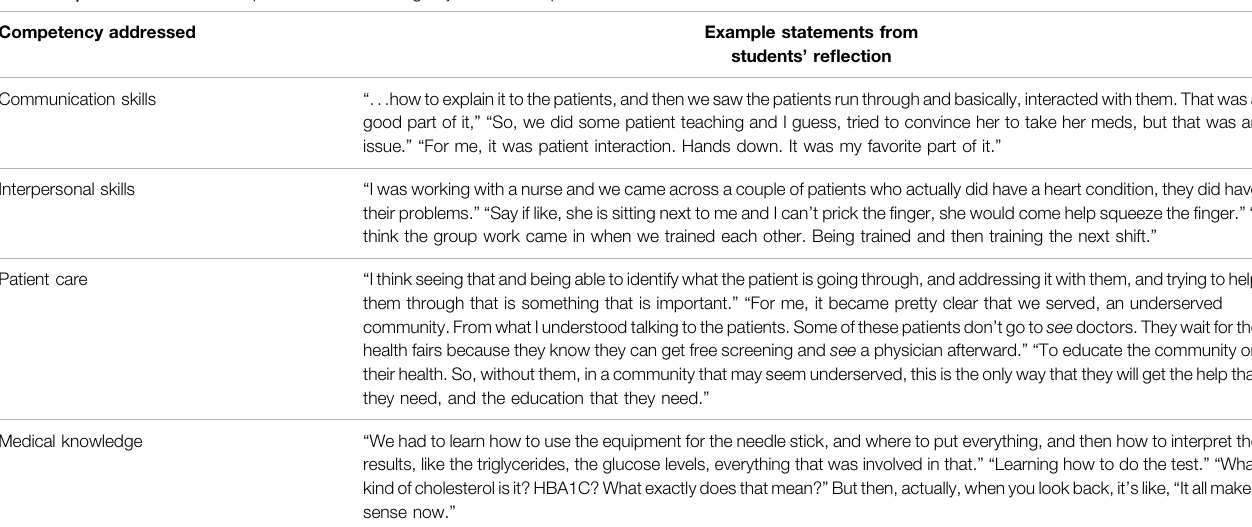
TABLE 6 | Attainment of the competencies and learning objectives with quotes from student re fl